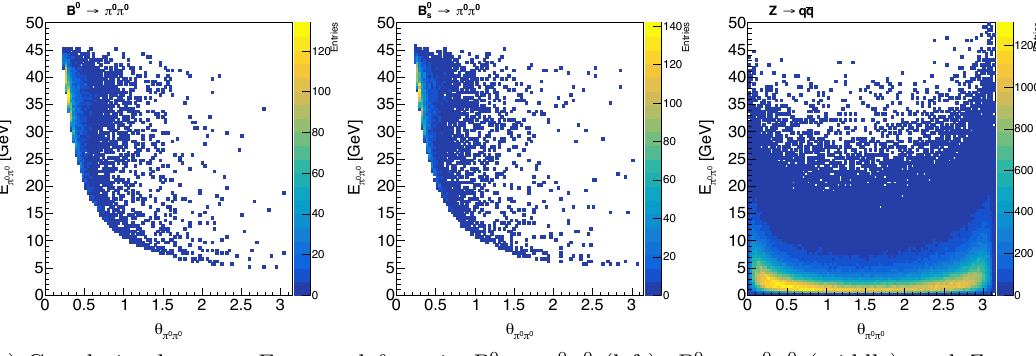
and θ in B 0 → π 0 π 0 (left), B 0 π 0 π 0 π 0 π 0